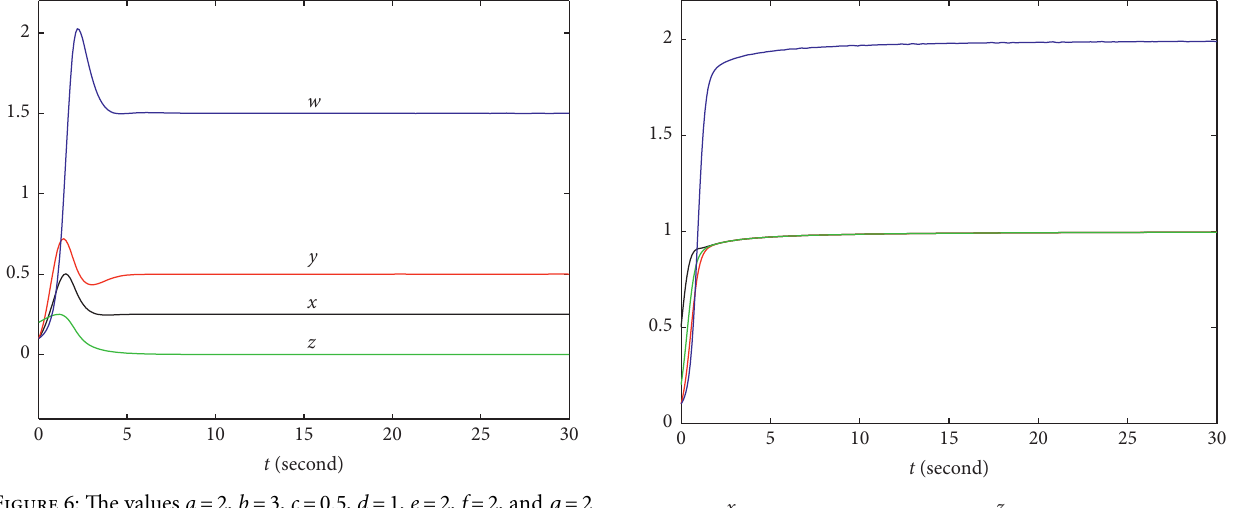
x y Figure 7: The values a � 4, b � 4, c � 4, d � 3, e � 2, f � 2, and g � 2 are used. So, we get the stable solution ( x � 1, y � 1, z � 1, and w �